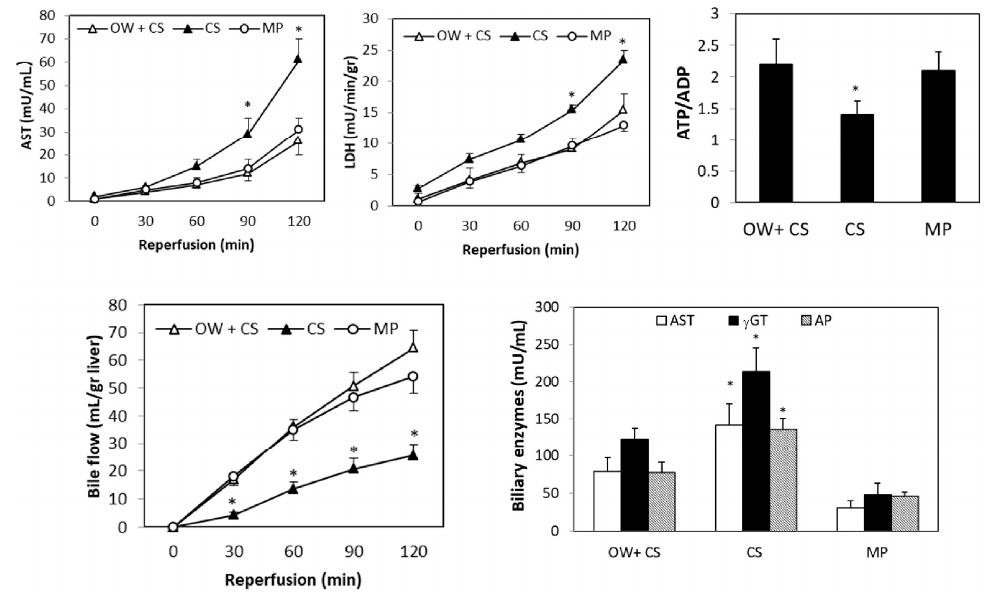
Figure 2. Effects of an oxygenated washout (OW) on enzyme release, ATP/ADP tissue ratio, bile flow and biliary enzymes: alanine-aminotransferase (AST); gamma-glutamyltranferase ( γ GT); alkaline phosphatase (AP) at the end of reperfusion. After 30 min ischemia, livers were submitted to OW + CS or CS or MP; after 6 h preservation, 2 h reperfusion was performed. The values are reported as means ± standard error (SE), n = 7/group. * <0.05 versus OW + CS or MP.